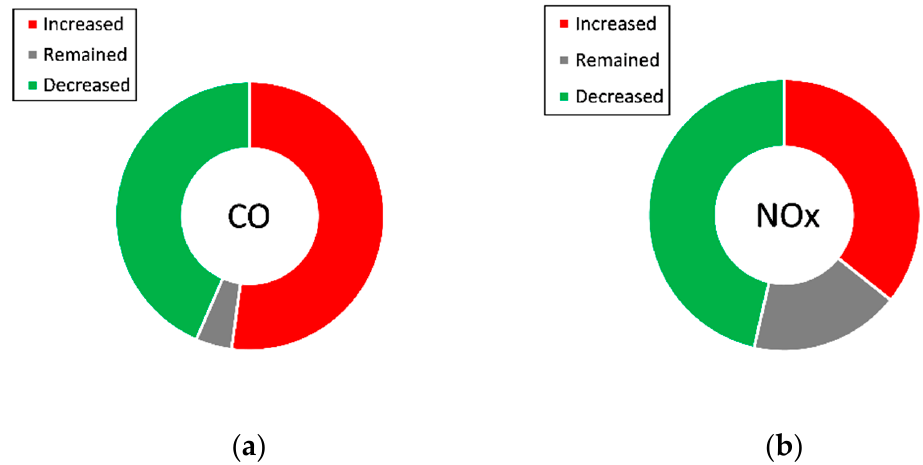
Figure 3. ( a ) Summary of CO emissions trends for butanol blends in diesel engines; ( b ) Summary of NO X emissions trends for butanol blends in diesel engines.